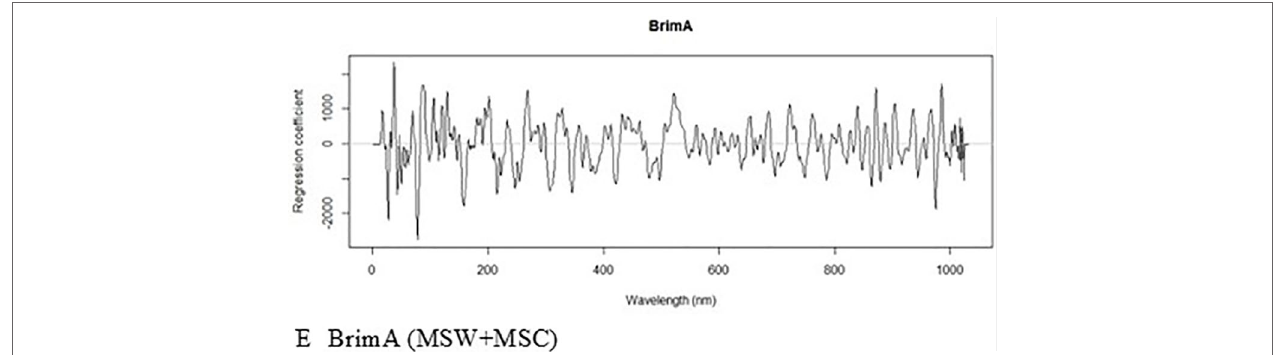
FIGURe 5 | Partial Least Squares (PLS) beta-coefficient plots obtained during the calibration construction process of (A) total soluble solids (TSS), (B) titratable acidity (TA), (C) TSS/TA ratio, (D) pH, and (e) BrimA.